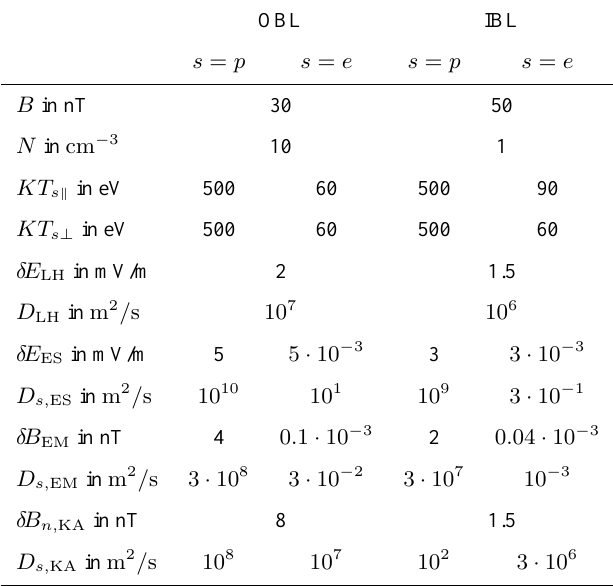
Table 2. Diffusion coefficients for solar wind particles in the OBL and IBL. The upper four rows give averages for the magnetic field magnitude, B , the density, N , and the field-aligned and perpen- dicular thermal energies, KT s k and KT s ⊥ , of solar wind protons ( s = p ) and electrons ( s = e ). These quantities are combined with typical amplitudes of electric and magnetic fluctuations in order to estimate proton and electron diffusion coefficients caused by lower hybrid drift instability ( D LH ), gyroresonant pitch-angle scattering due to electrostatic ( D s, ES ) and electromagnetic ( D s, EM ) waves, and by kinetic Alfv´en wave turbulence ( D s, KA ). The relevant wave amplitudes are given one row above the respective diffusion coeffi- cients